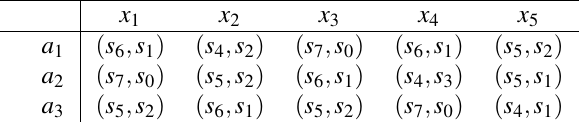
Table 7. Decision matrix R 3